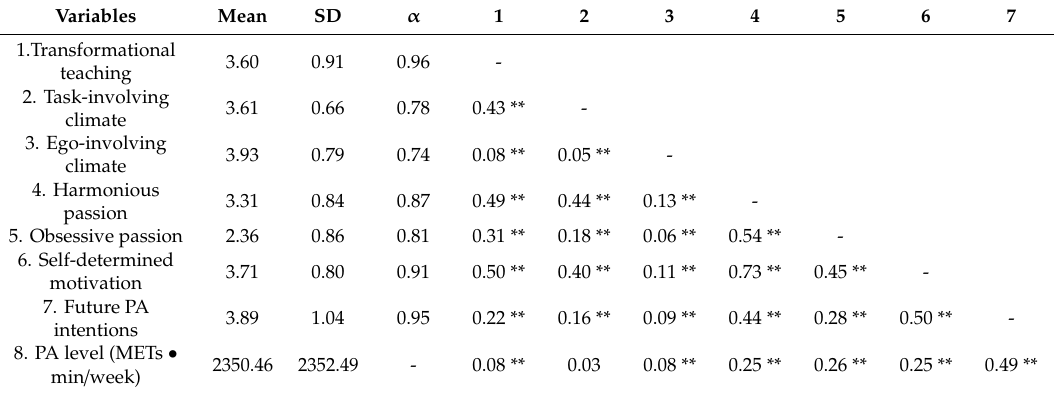
Table 1. Descriptive statistics, internal consistency and correlations between study